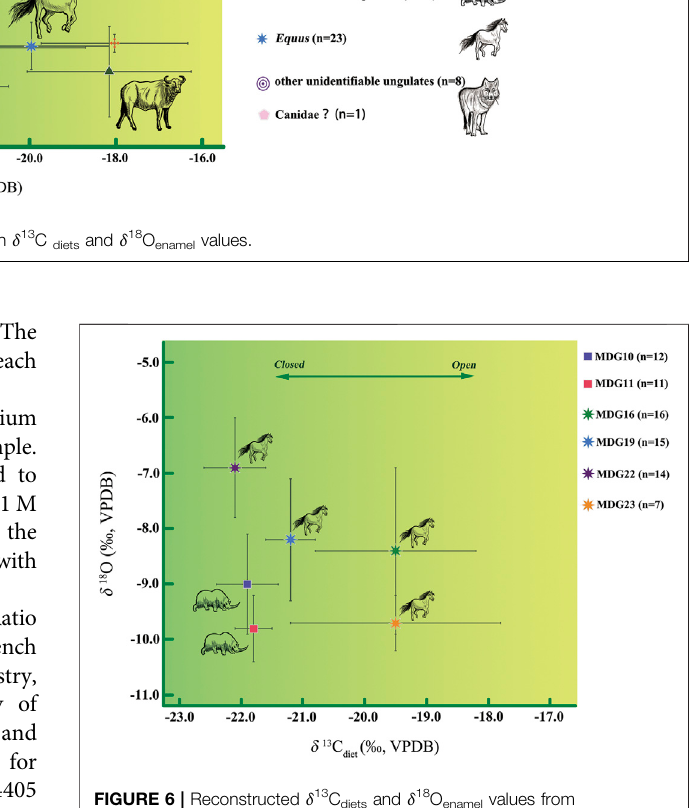
FIGURE 6 | Reconstructed δ 13 C diets and δ 18 O enamel values from sequential samples of MDG teeth. MDG10 and MDG11: Coelodonta antiquitatis . MDG16, 19 and 22: Equus wangi sp. Nov. MDG23: Equus qingyangensis sp.